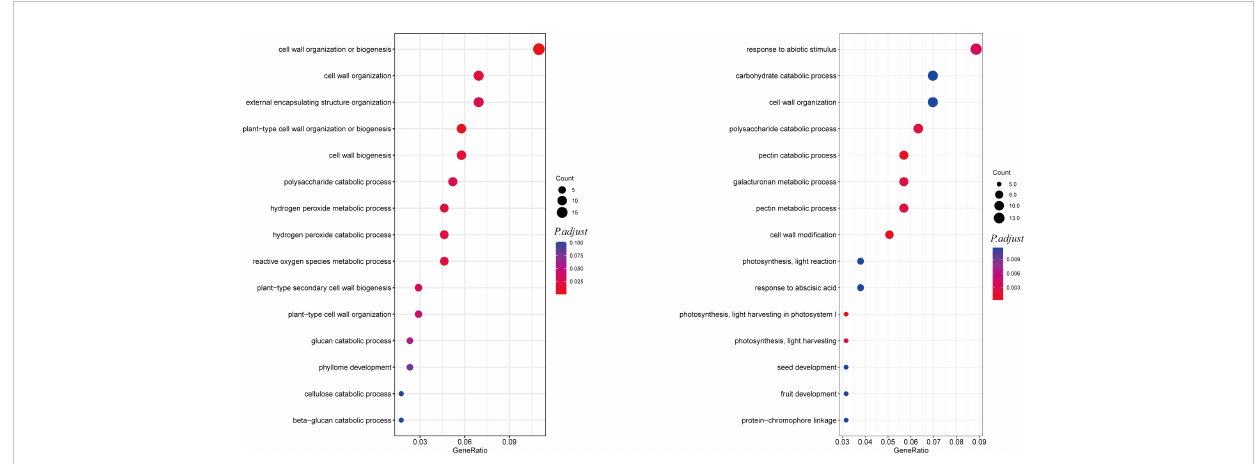
FIGURE 4 Dotplot of GO enrichment based on up- and down-regulated DEGs from comparing OE-S vs. WT-S. The dotplot GO enrichment of up-(left) and down-(right) regulated DEGs. The y-axis represents GO pathways; the x-axis indicates the gene ratio. The size of the dot is the number of the DEGs that enriched. The color of the dot is the P -value, more redder means more signi fi cant